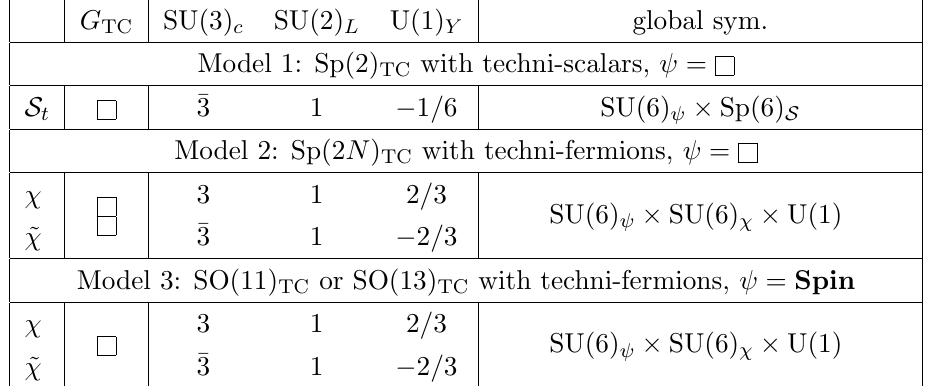
Table 2 . FCD models that generate partial compositeness in the con(cid:12)ned phase. In Model 1, techni- scalars are added in the same representation as the techni-fermions (speci(cid:12)cally for Sp(2)). In Mod- els 2 and 3, the composite fermions are made of 2 ’s and an additional fermion (cid:31) in a di(cid:11)erent FCD representation. In all models, the component of transform under the SM interactions as in table